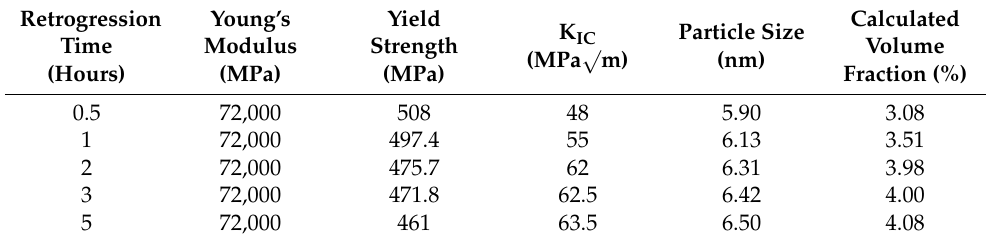
Table 2. The calculated volume fraction of η ’